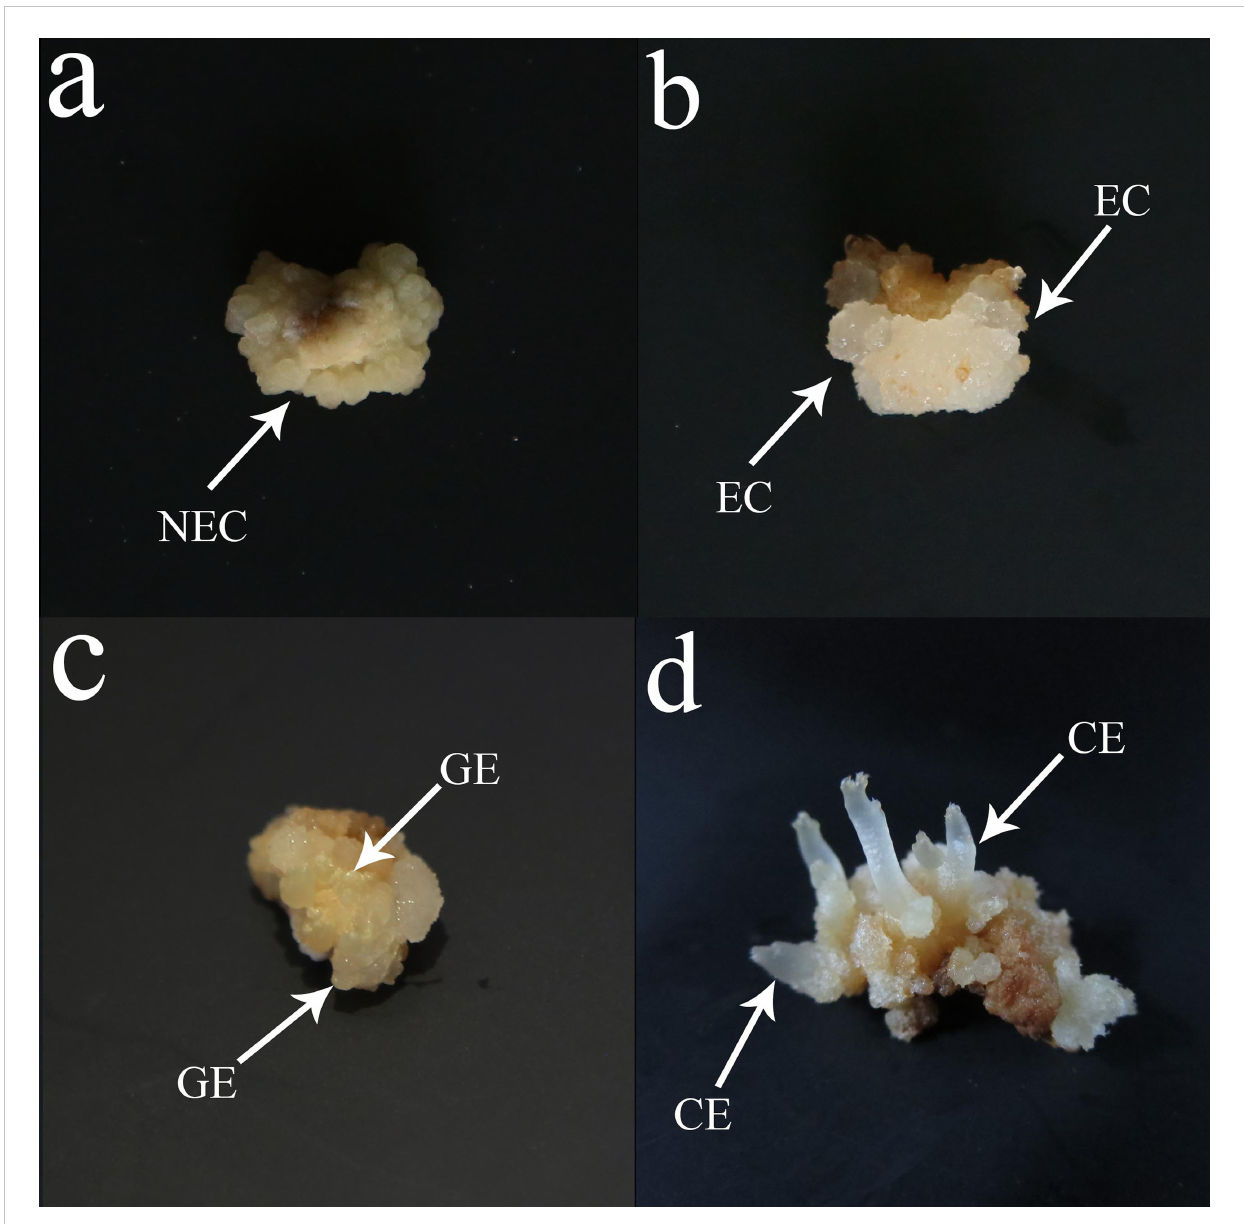
FIGURE 1 Somatic embryogenesis in O. henryi. (A) Nonembryogenic callus (NEC), (B) Embryogenic callus (EC), (C) Globular embryo( GE), (D) Cotyledon embryo (CE), bar=0.5